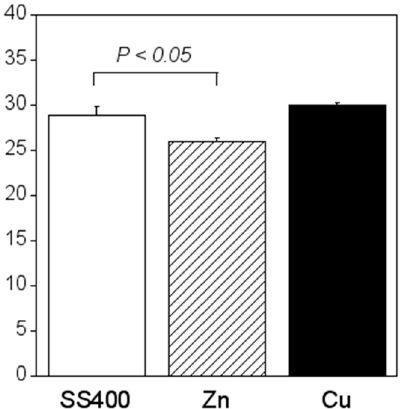
Figure 7. Biofilm quantification of outdoor-exposed coupons. Each column shows the mean of the modulus of ( a ∗ ) 2 + ( b ∗ ) 2 + ( 100 − L ∗ ) 2 (n = 5). Zn and Cu mean Zn-coated coupons and Cu-coated coupons, respectively. Error bars show the standard deviation. Student’s t-test was performed between the SS400 coupons and Zn-coated coupons or SS400 coupons and Cu-coated coupons. P means the p-value.